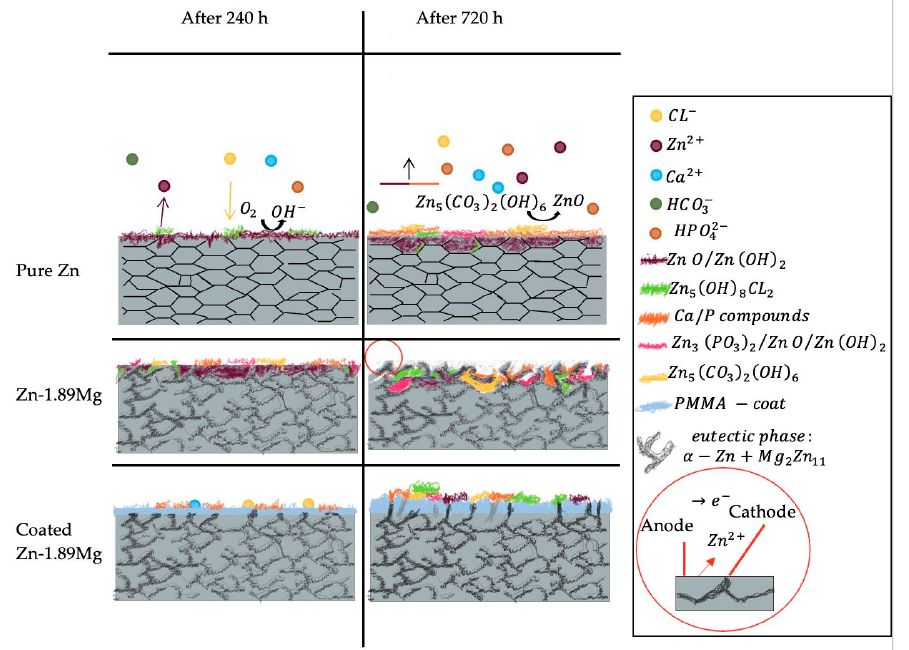
Figure 11. Schematic diagrams of the attack evaluation of pure Zn, Zn-1.89Mg, and PMMA-coated Zn-1.89Mg during immersion in SBF.